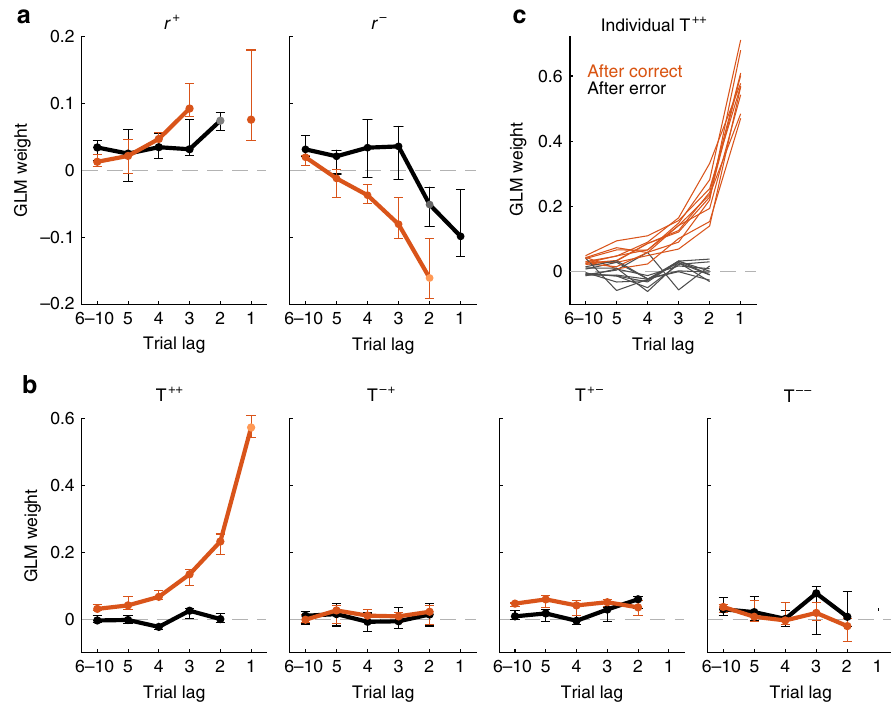
Fig. 4 Fitted weights quantifying the impact of the lateral and transition biases onto animals decisions. In fl uence of past events on current choice when separately fi tting the choices in trials after a correct (orange) or an error response (black). a GLM weights of previously rewarded ( r + , left panel) and unrewarded ( r − , right panel) responses. These kernels quantify the in fl uence on choice of the side (left vs. right) of previous responses. b Weights of previous transitions (repetition vs. alternation) computed separately for T ++ (a rewarded trial followed by a rewarded trial), T − + (error-rewarded), T + − (rewarded-error), and T −− (error-error). Strong positive weighting of T ++ transitions after-correct responses revealed that animals tended to reproduce previous repetitions and alternations between two consecutive rewarded trials. Points in a and b show median coef fi cients across animals ( n = 10) and error bars indicate fi rst and third quartiles. c Transition kernels for individual animals show the ubiquity across subjects of the reset of the kernel after errors. Some weights at trial lags 1 and 2 are not shown because of existing indeterminacies between regressors (see Supplementary Methods Section